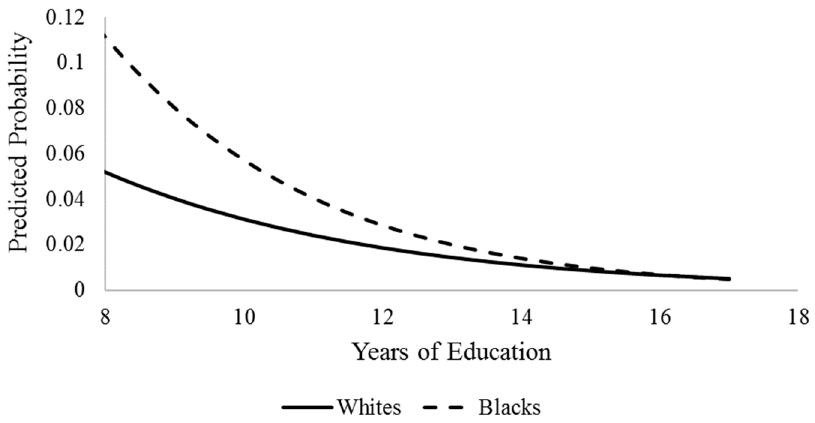
Figure 1. Race by Education Interaction Predicting Cognitive Impairment, HRS 2012.